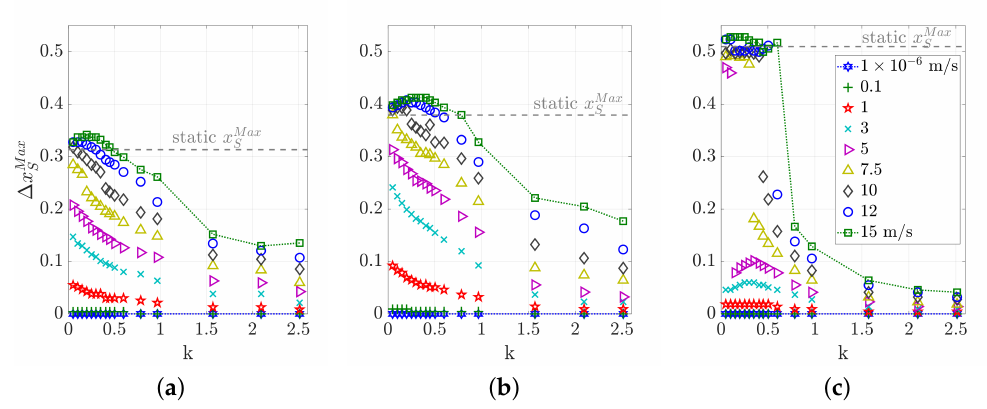
Figure 14. Maximum shock motion during one period of excitation. ( a ) Mach 0.66, ( b ) Mach 0.68, ( c ) Mach